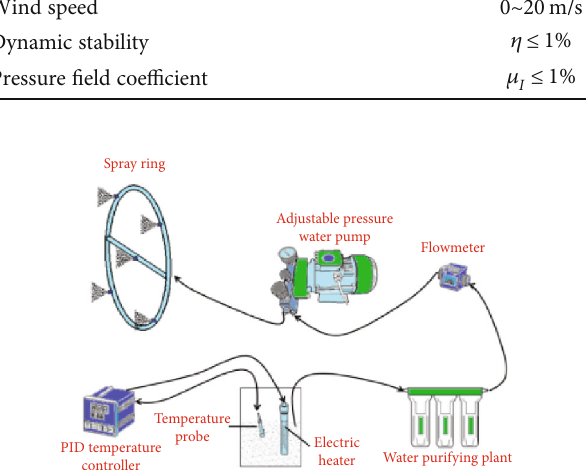
Figure 2: Spray system.